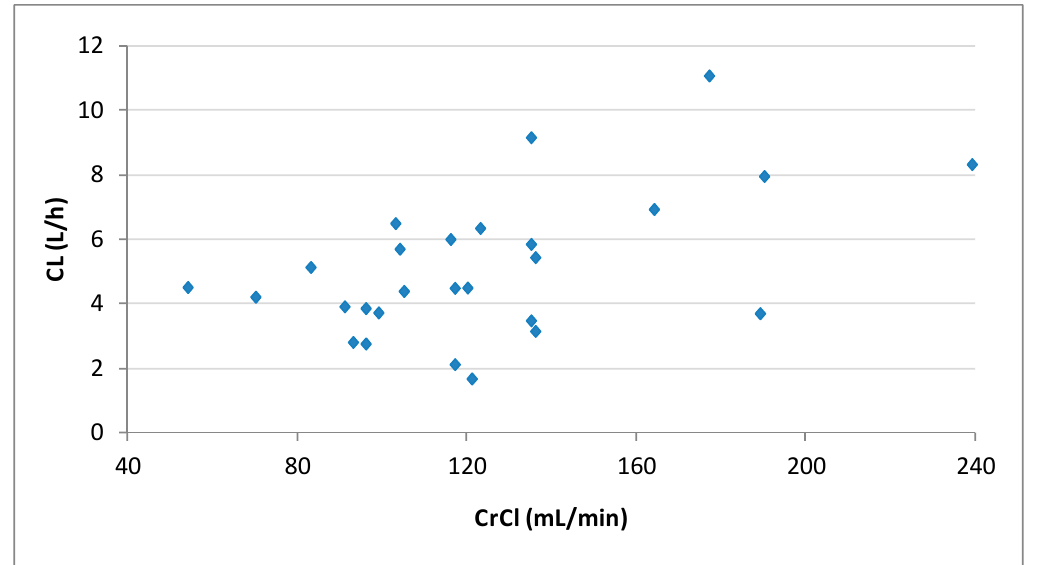
Figure 2. Plot of the individual levetiracetam clearances (CL) calculated by noncompartmental analysis vs. creatinine clearances (CrCl) for the 27 patients.